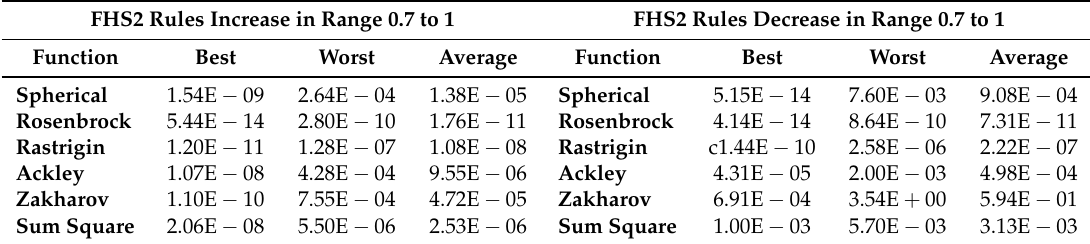
Table 7. Results obtained with FHS2 using fuzzy logic to increase and decrease PArate with a range from 0.7 to 1, applied to 6 benchmark mathematical functions.